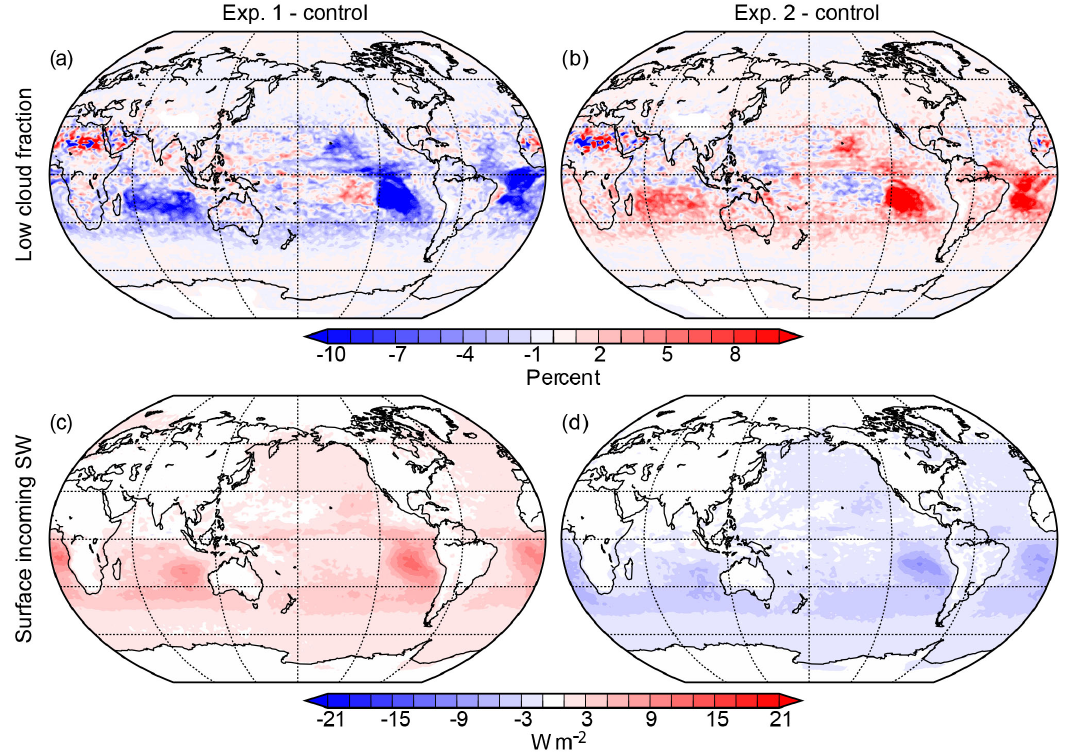
Figure 9. Comparisons of the low cloud fraction (as a percentage) (a–b) and incoming SW radiation at surface (Wm − 2 ) (c–d) over the 2000–2009 period for Exp.1 (first column) and Exp.2 (second column) minus the Ctl. The absolute values for the Ctl of these fields can be seen in Figs. 3 and